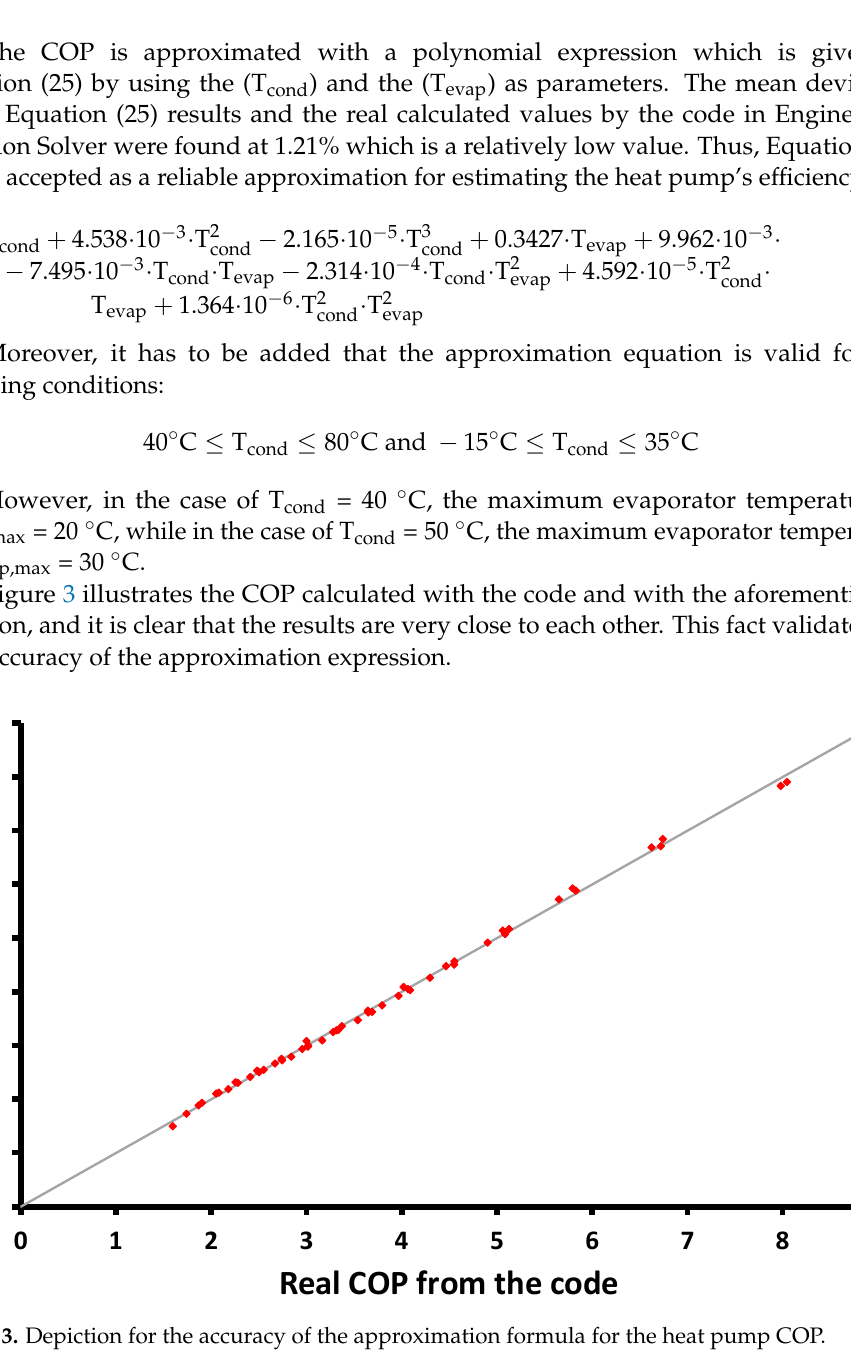
Figure 3. Depiction for the accuracy of the approximation formula for the heat pump COP.